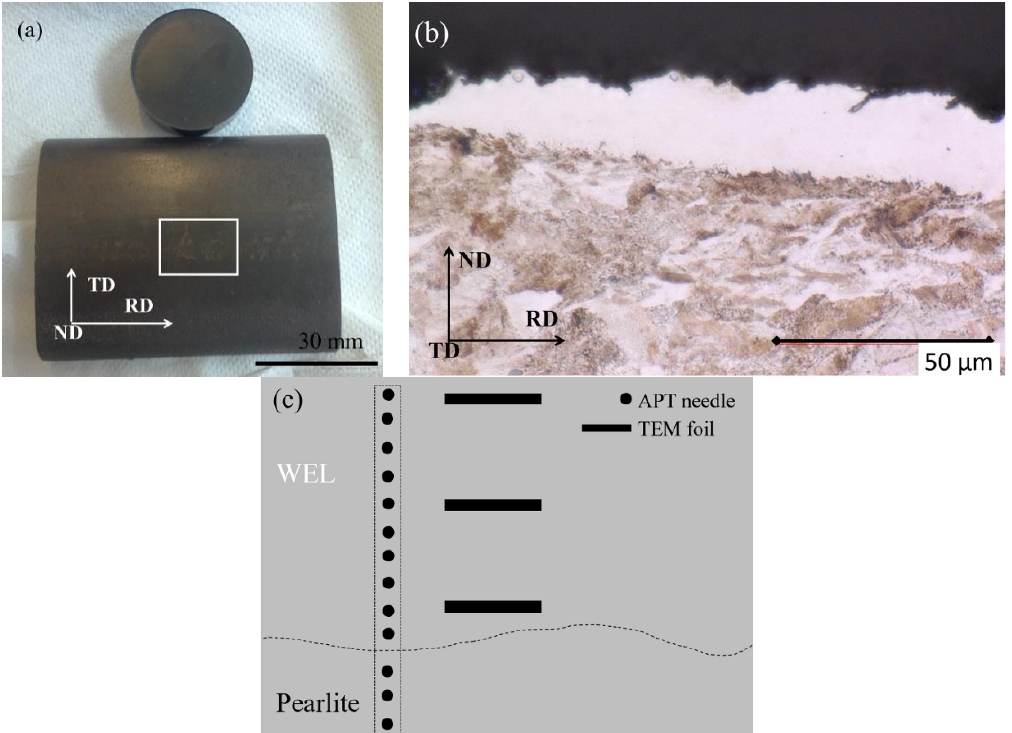
Figure 1. ( a ) An overview of the rail surface after grinding and subsequent etching with 2% Nital; ( b ) optical micrograph of a cross-sectional specimen, cut across one of the WEL blocks enclosed in the white rectangle shown in ( a ); ( c ) magnified view of the region enclosed in the white rectangle shown in ( b ), with positions of APT-pillar and TEM-lamellae extraction indicated.